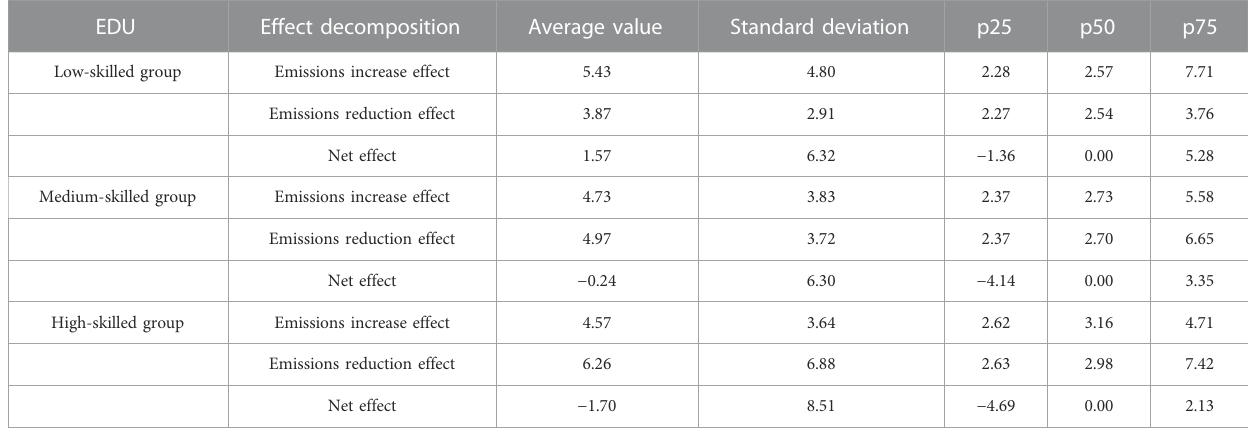
TABLE 7 Differences in the impact of the digital economy (%) on air pollution under different levels of human capital.